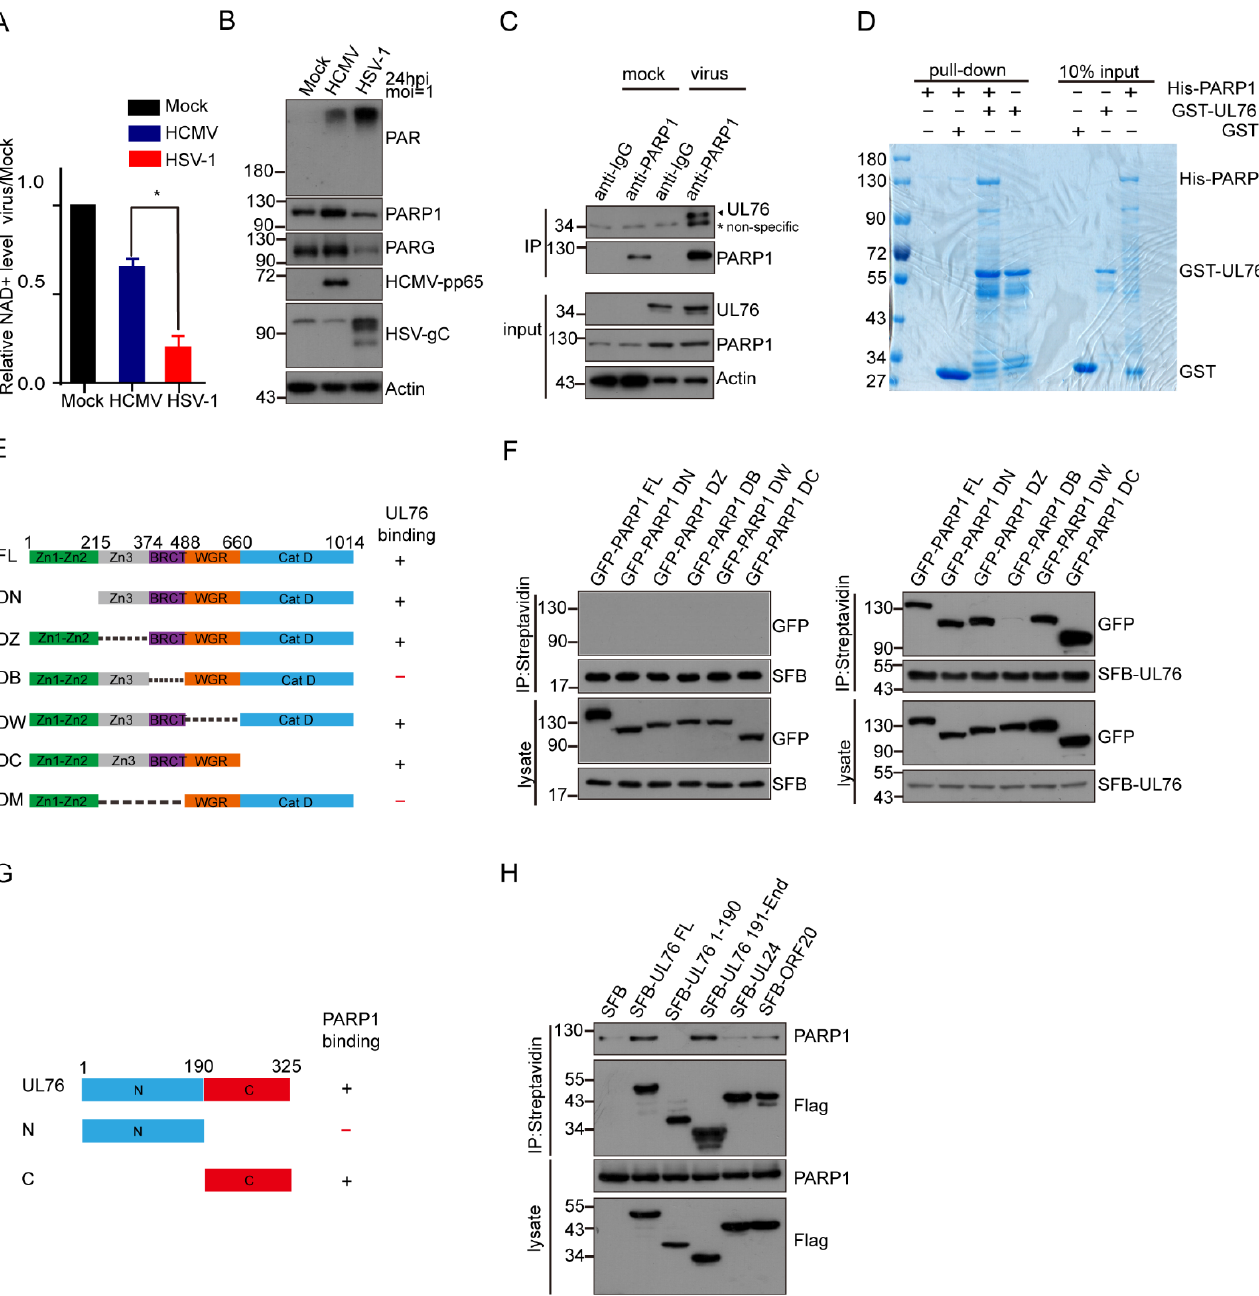
Figure 4. HCMV UL76 binds to the BRCT domain of PARP-1 through its C terminal. ( A ) NAD + levels declined to varying degrees upon HSV-1 and HCMV infection. Fibroblasts were infected with HSV-1 (F strain) or HCMV (AD169 strain) at an MOI of 1. Cells were collected at 24 hpi by trypsin digestion and lysed in a NAD + extraction buffer. NAD + levels in these cells were normalized to total protein and compared to mock-infected cells. Values are averages of triplicate experiments (±1 SD), * p < 0.05. ( B ) Protein PARylation and the protein levels of PARP-1 and PARG were compared between HSV-1- and HCMV-infected cells. MRC-5 cells were infected with HSV-1 or HCMV at an MOI of 1. Pp65 of HCMV and glycoprotein C of HSV-1 served as infection markers for each virus. The whole cell lysates were analyzed by indicated antibodies. ( C ) HCMV tegument protein UL76 was a PARP-1 binding protein. MRC-5 cells were infected or mock infected with HCMV at an MOI of 1 for 96 h. Cells were harvested and lysed in NETN 420 in the presence of protease inhibitors. Cell lysates were prepared and subjected to immunoprecipitation with PARP-1 antibody or control IgG. The presence of PARP-1 and UL76 in the immune complexes was determined by Western blot analysis. * indicates nonspecific band. ( D ) UL76 directly interacts with PARP-1 in vitro. Purified